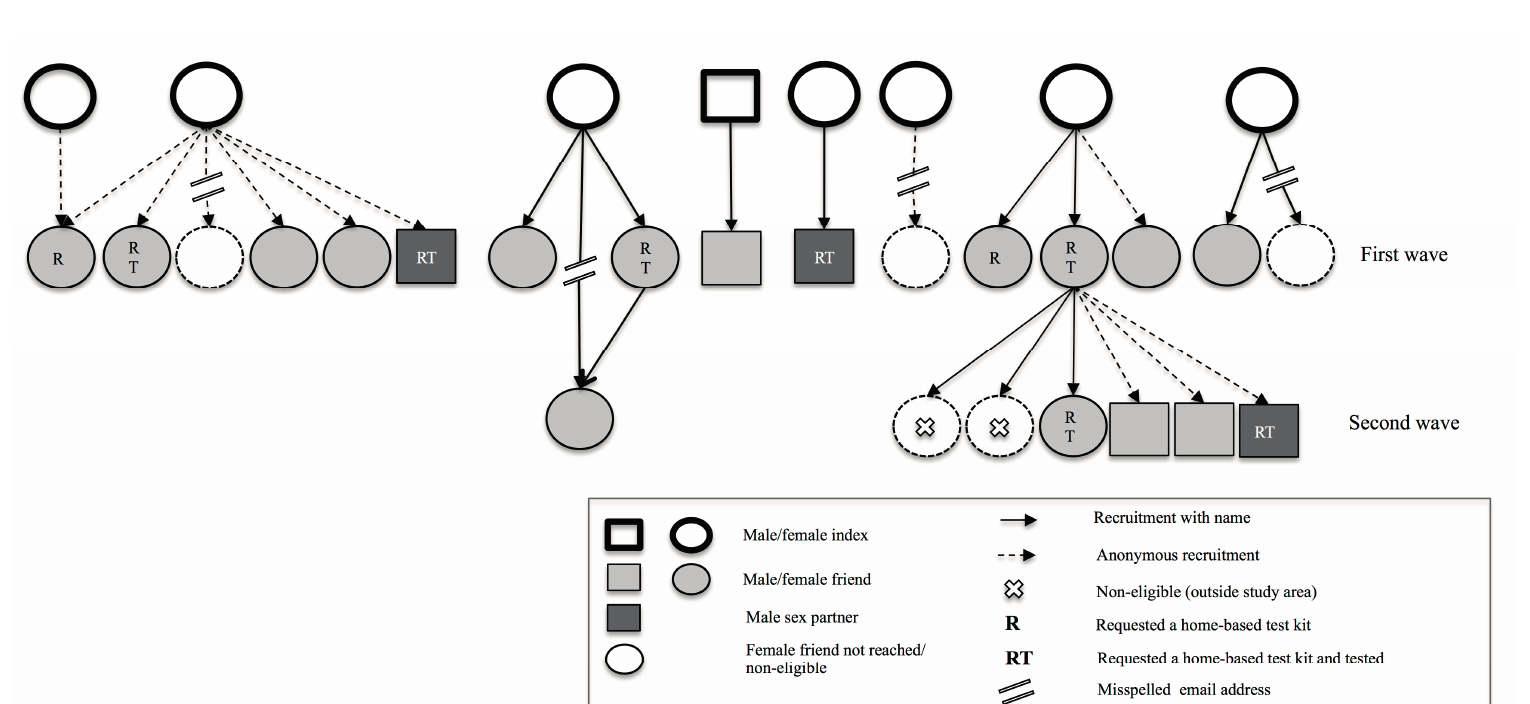
Figure 2. Recruitment among index clients and first wave